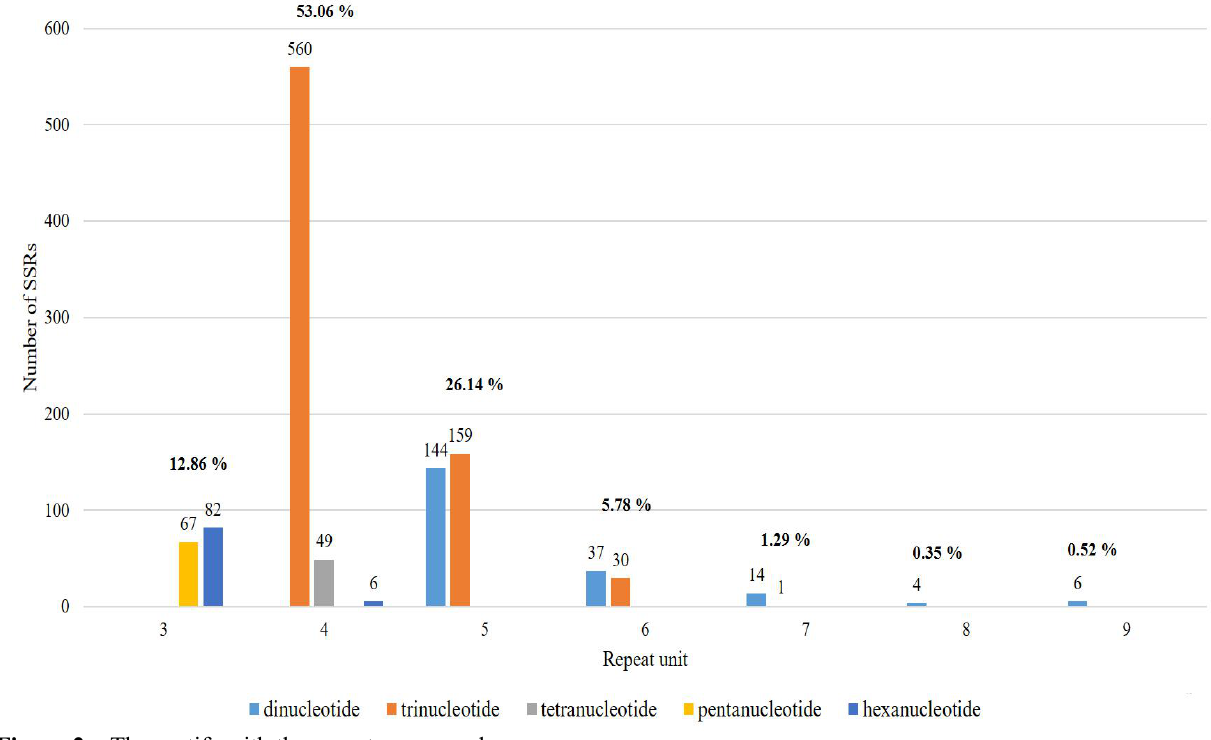
Figure 2. The motifs with the repeat copy number.